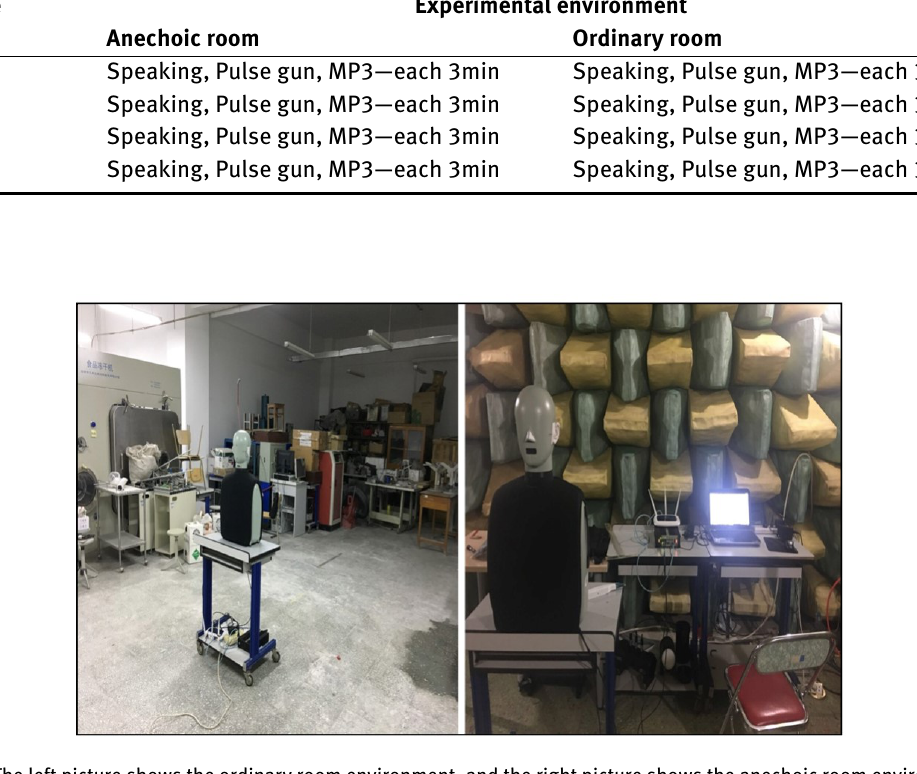
Figure 6: The left picture shows the ordinary room environment, and the right picture shows the anechoic room environment